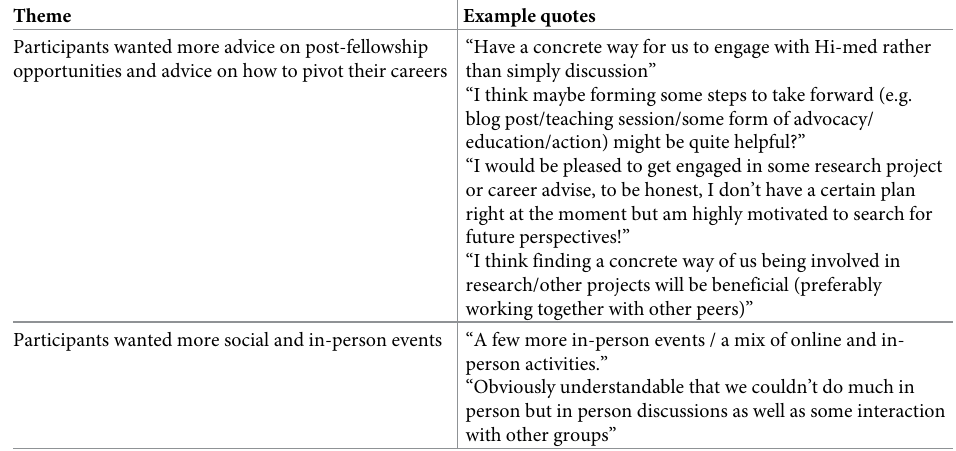
Table 4. Areas of improvement for the